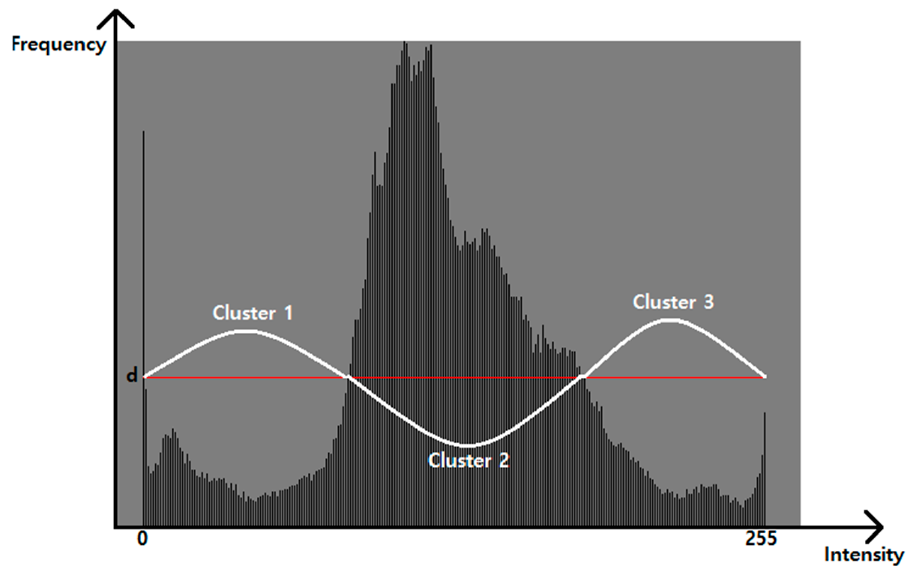
Figure 3. Histogram analysis for DBSCAN algorithm.